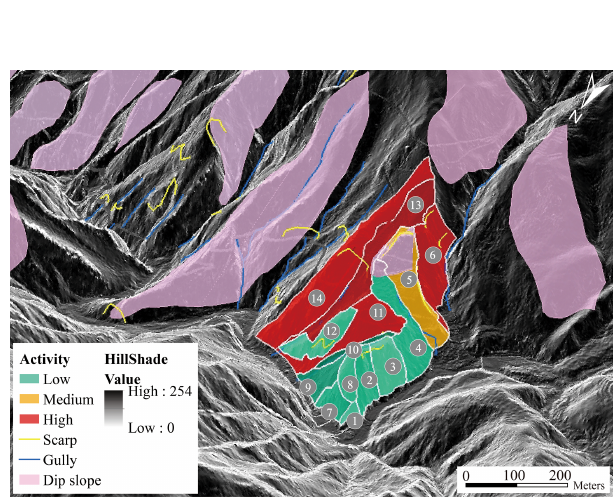
Figure 7. Activity level referring to slope units around the Neikui- hui tribe (background: modified from 2020 data from the Depart- ment of Lands, Ministry of the Interior, for research purposes only; aerial: ESRI ArcGIS